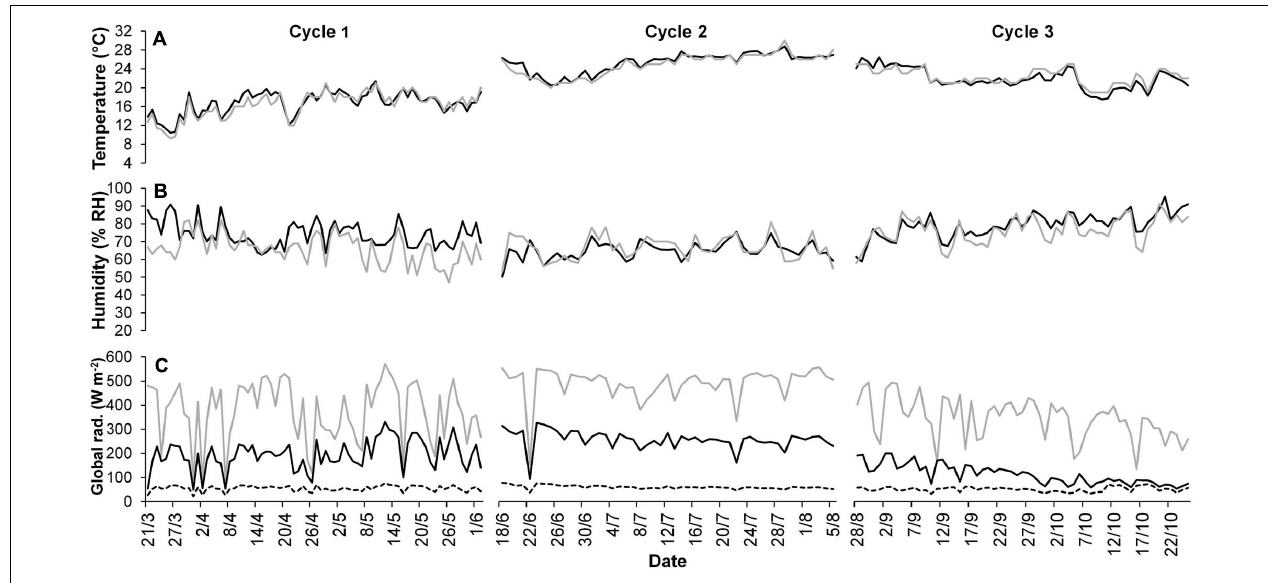
FIGURE 3 | Average daily temperature (A) and humidity (B) inside the greenhouse (black line) and outside (gray line) during the three crop cycles. The average daily global irradiance ( I g ) (C) is depicted under the plastic cover (black line), the photovoltaic cover (dotted line) and outside (gray line).